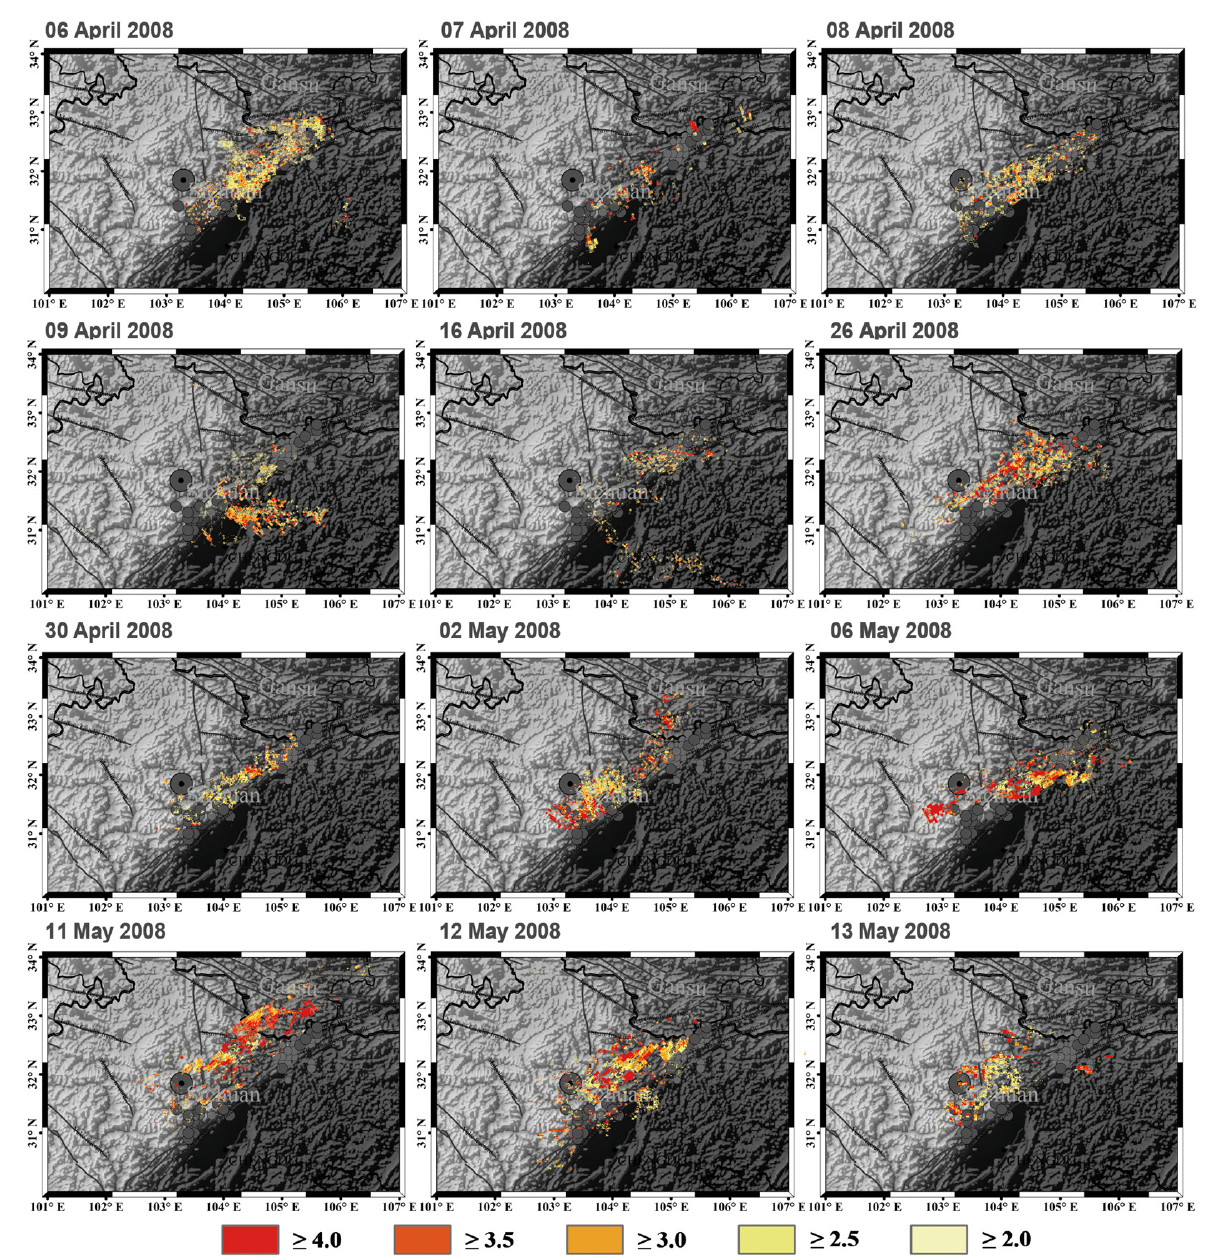
Figure 5. Results of the RETIRA index computation on the investigated area before and after the Yingxiu-Beichuan fault using AATSR BT data (Nadir view) from April 6, 2008, to May 13,